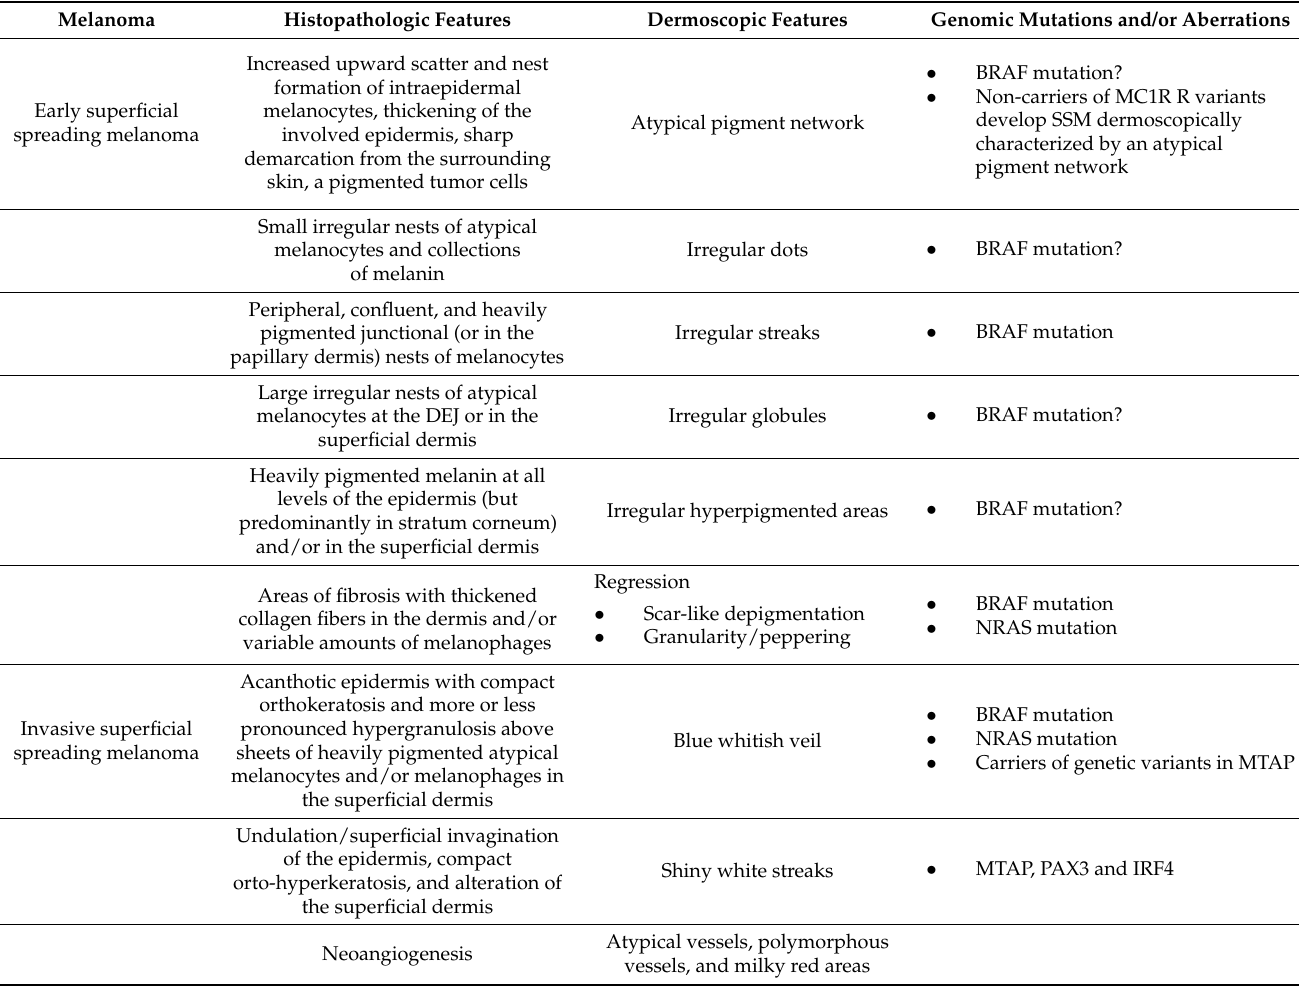
Table legend: SSM: superficial spreading